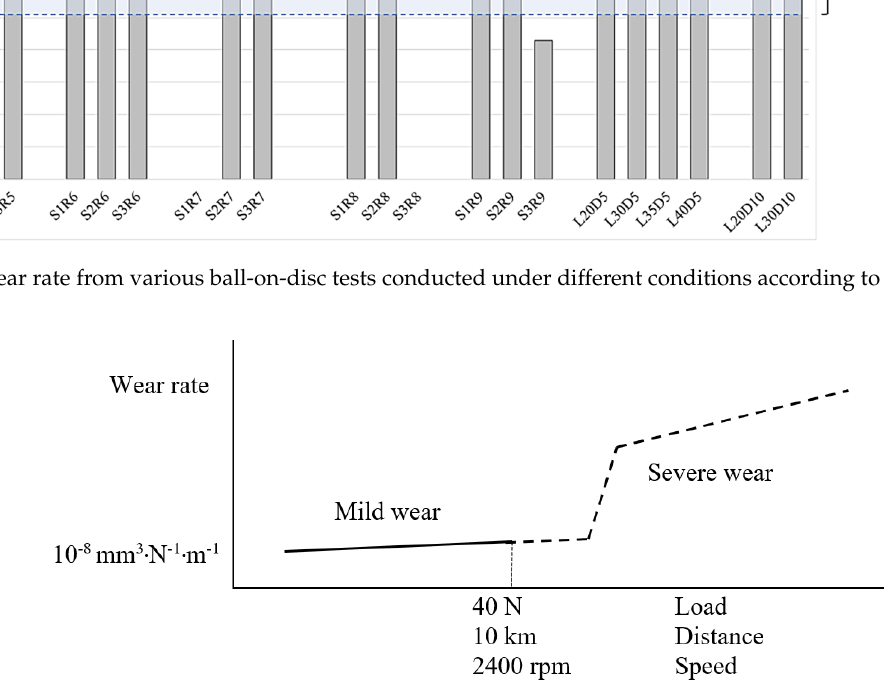
Figure 13. Schematic diagram of the mild and severe wear regimes adapted from [1].